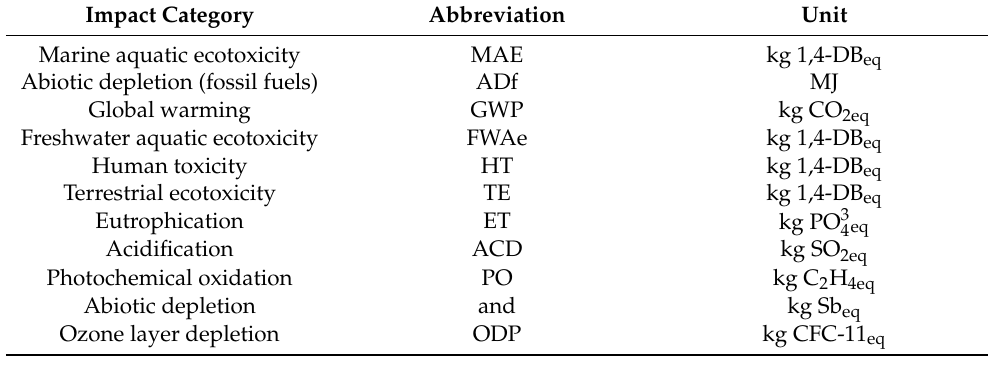
Table 2. Selected impact categories, their abbreviations, and the measurement units.